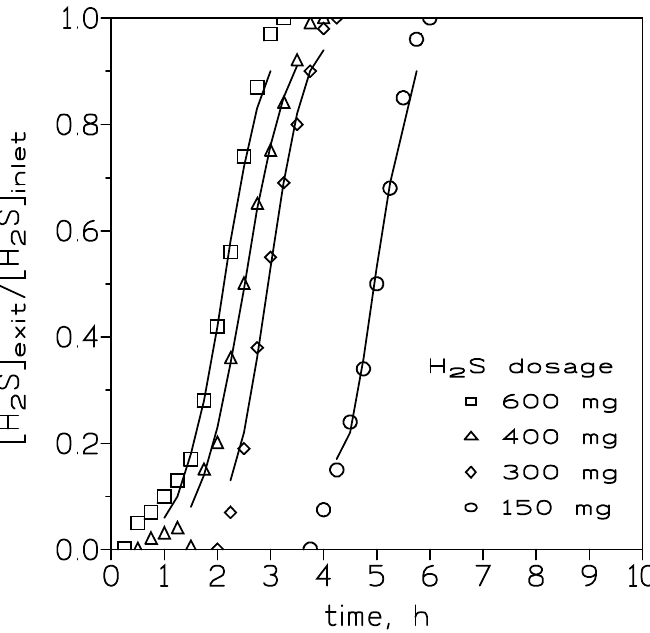
Figure 2. Experimental (points) and model (lines) breakthrough curves at various inlet H 2 S dosages. Adsorbent dosage: 4 g. Gas flow: 420 cm 3 /min. Temperature: 20 ◦ C. Table 2. H 2 S loading at the breakthrough point at various inlet H 2 S dosages.